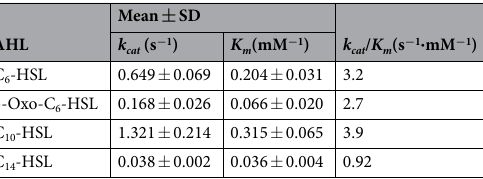
Table 1. Kinetic constants of AiiK for degrading AHLs. Note: Reactions were performed at pH 7.4 and 25 °C. And all data in this study were exbihited as mean ± the standard deviation